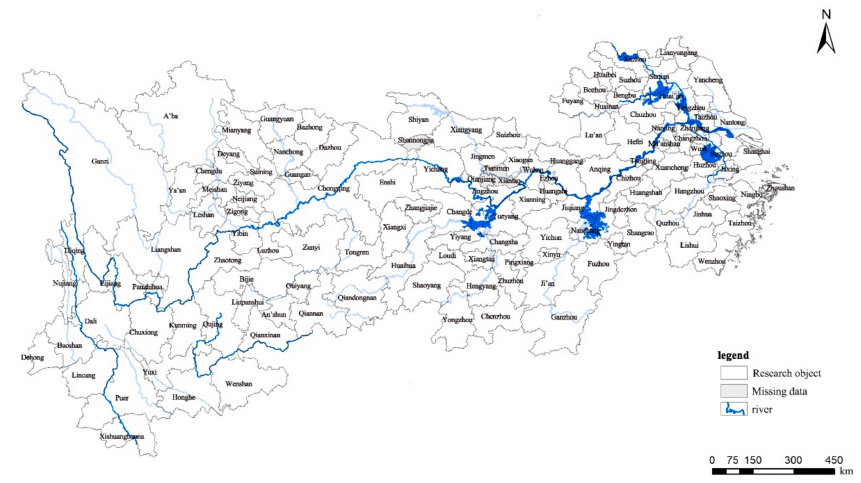
Figure 1. Research